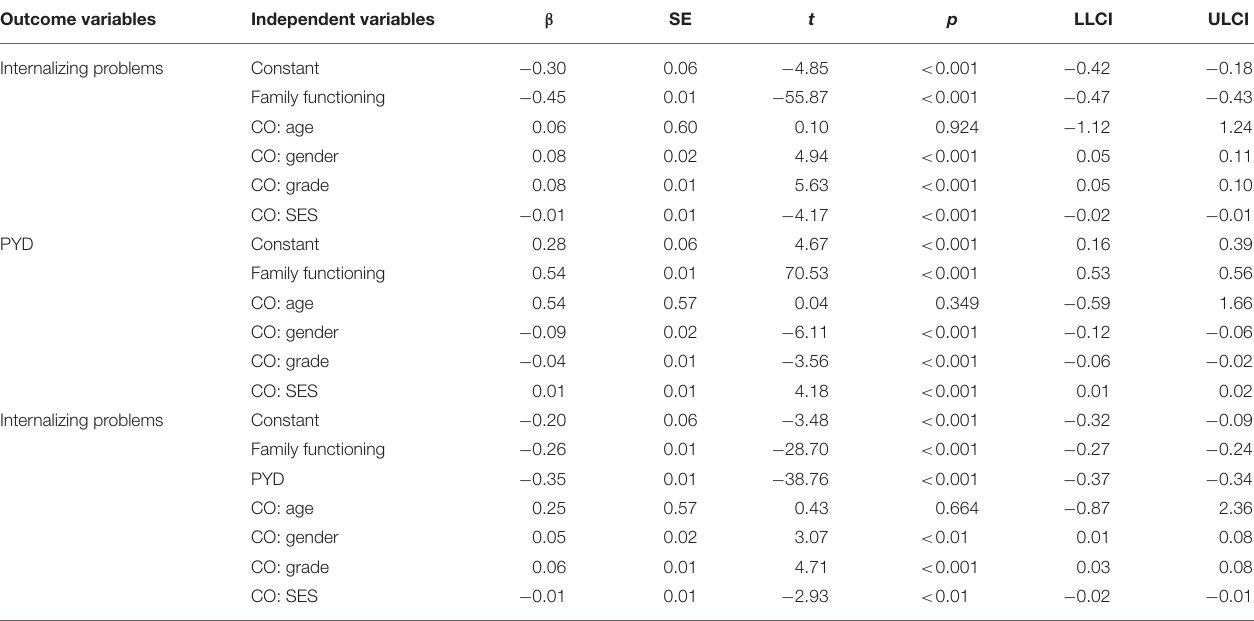
TABLE 2 | Testing the mediation effects of family functioning on internalizing problems. Outcome